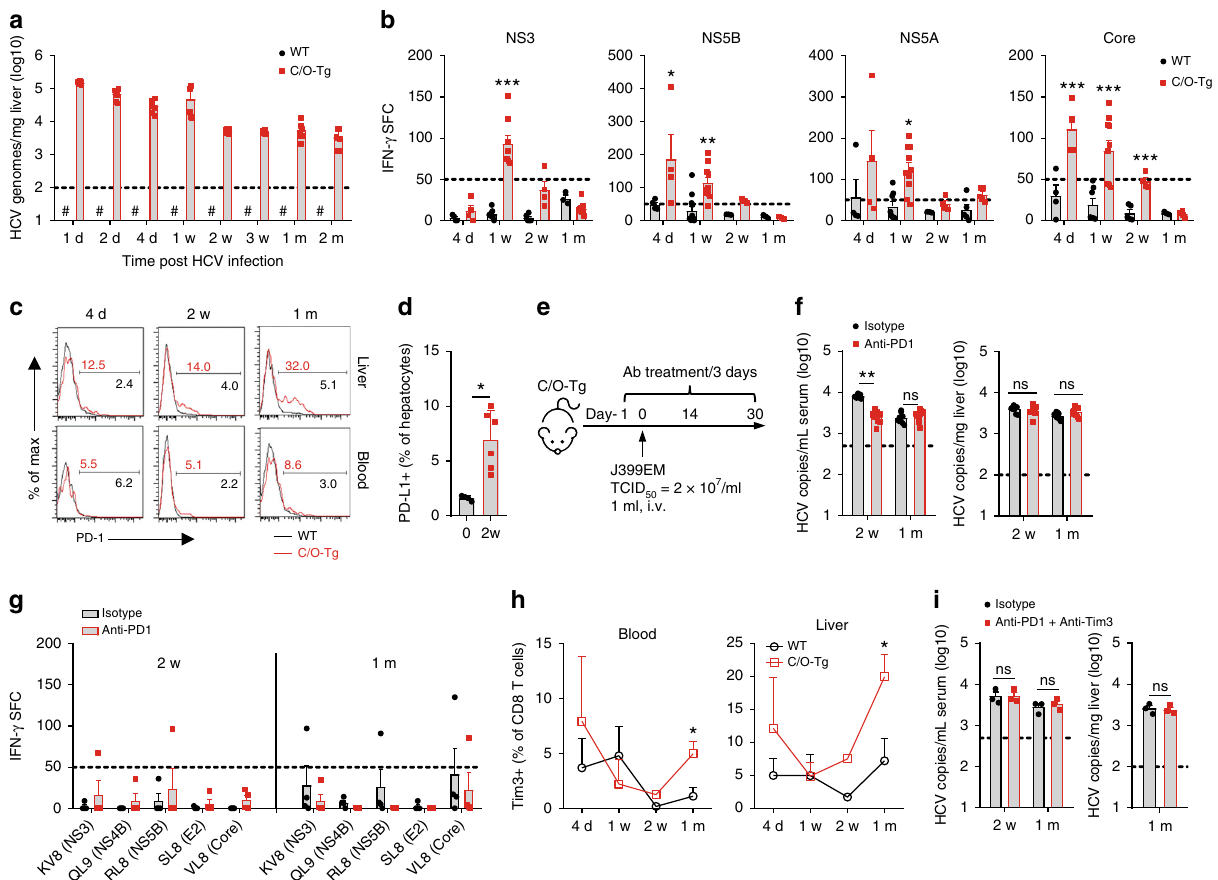
Fig. 1 CD8 + T cell exhaustion and PD-1 blockade. C/O Tg ( n = 55, n ≥ 6 for each time point) or wt mice ( n = 32, n = 4 for each time point) were i.v. infused with 1 mL HCV J399EM (TCID 50 = 2 × 10 7 /mL). Mice were killed and blood, splenocytes, hepatocytes, and NPCs were collected at indicated time. a HCV RNA copies in hepatocytes were measured by qPCR. b The number of IFN- γ spot-forming cells (SFCs) by ELISpot assay determined 2.5 d after in vitro stimulation of splenocytes with respective epitope peptides, subtracted the SFC of OVA stimulation as the background. c FACS measurement of PD-1 expression in circulating or hepatic CD8 + T cells at indicated time post HCV infection. d FACS analysis of PD-L1 expression on hepatocytes isolated from naive ( n = 4) or HCV-infected C/O Tg mice ( n = 6) 2 wpi. e C/O Tg mice ( n = 9 for each group) were i.p. injected with PD-1 blocking antibody or isotype Ig (200 μ g/3 days) 1 day before HCV inoculation. f HCV RNA copies in serum and livers, and g HCV-speci fi c T cells response to the indicated epitopes. h FACS analysis of Tim-3 expression on peripheral and liver CD8 + T cells. i qPCR measurement of HCV RNA copies in the liver or blood after C/O Tg mice ( n = 3 for each group) were i.p. injected with PD-1 (200 μ g/3 days) plus Tim-3 (100 μ g/2 days) blocking antibody or isotype IgG 1 day before HCV inoculation. Dash lines indicated limits of detection of related assays (qPCR: 100 copies/mg liver, 500 copies/mL serum; ELISpot: 50 spots/4 × 10 5 splenocytes). #, below detection limit. Data were mean ± SD, Student t- test in b , d , f , h , and i . * P < 0.05; ** P < 0.01; *** P < 0.001. ns Not signi fi cant.